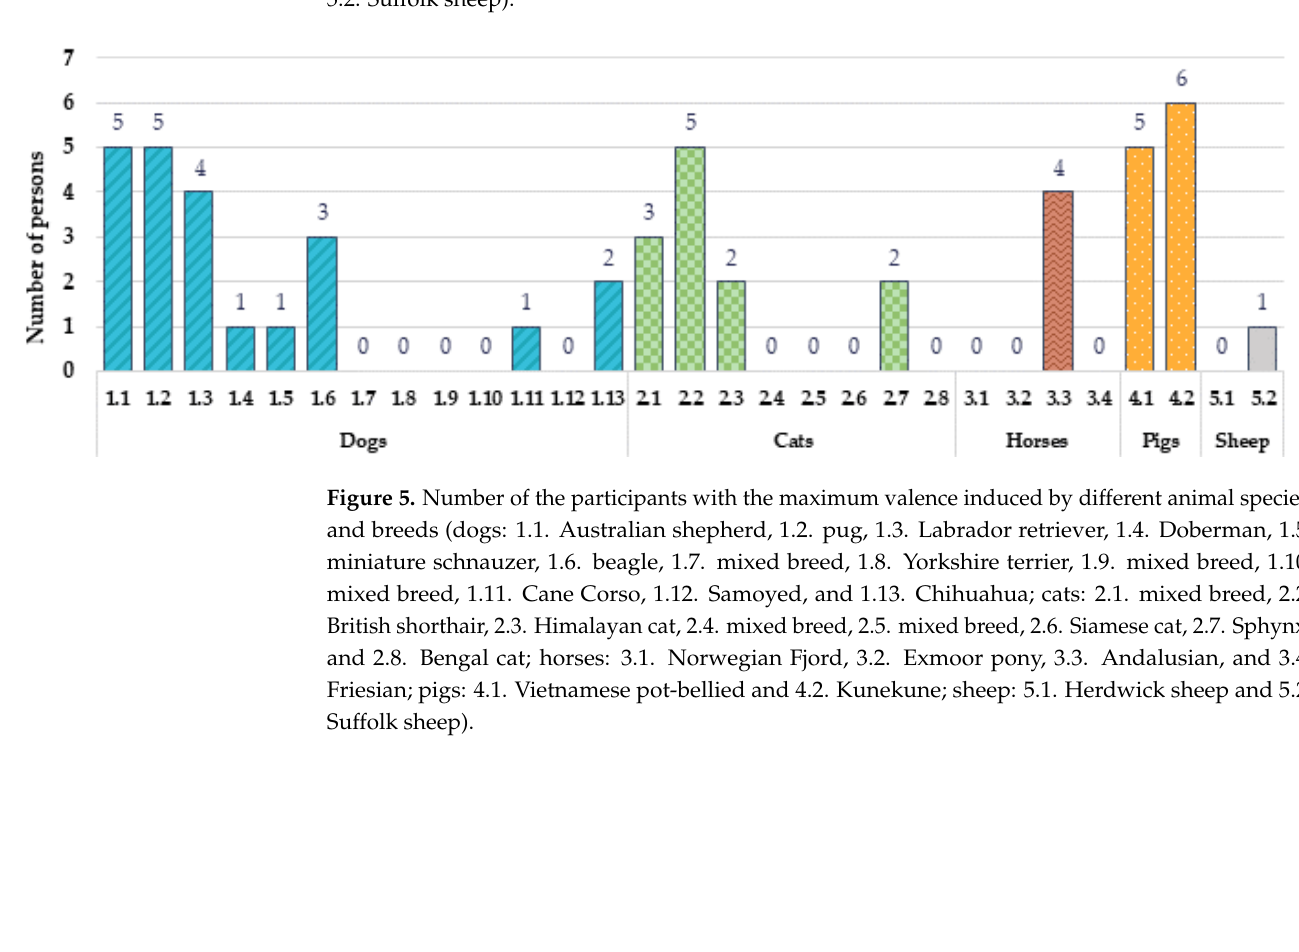
Table 2. Significance of the analyzed factors and their interaction with different animal species and breeds on the emotions induced in